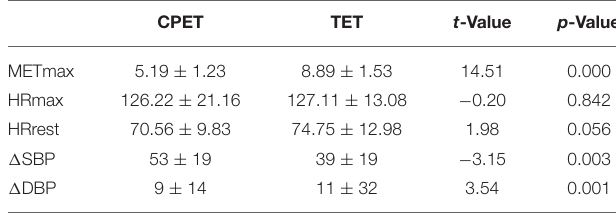
TABLE 1 | Subject characteristics ( n = 41). TABLE 2 | Comparison of the two kinds of exercise